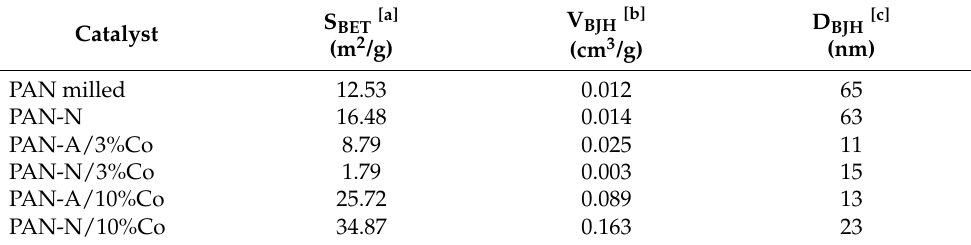
Table 2. Textural properties obtained for PAN and Co-N-doped carbon representative materials obtained by nitrogen physisorption